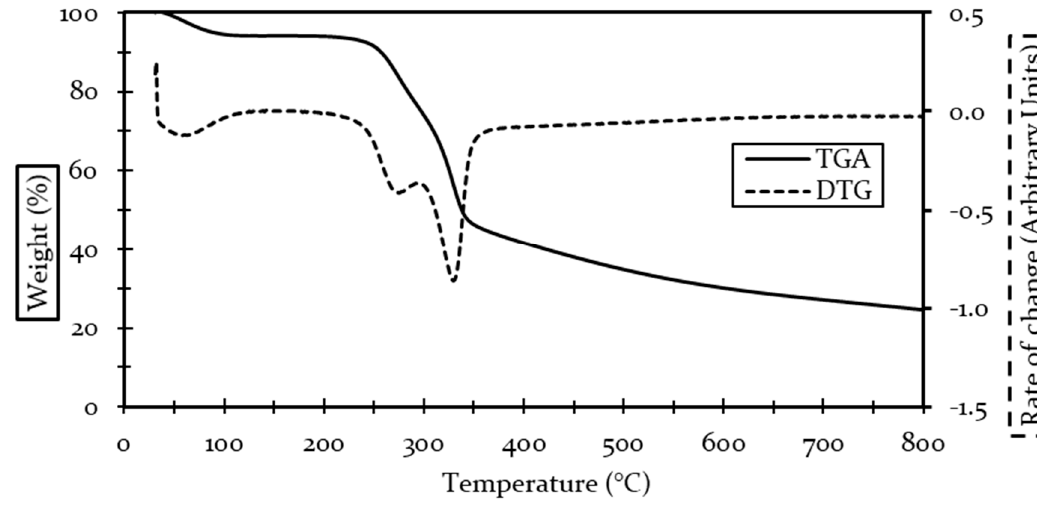
Figure 1. TGA and DTG curves for coir fibers.